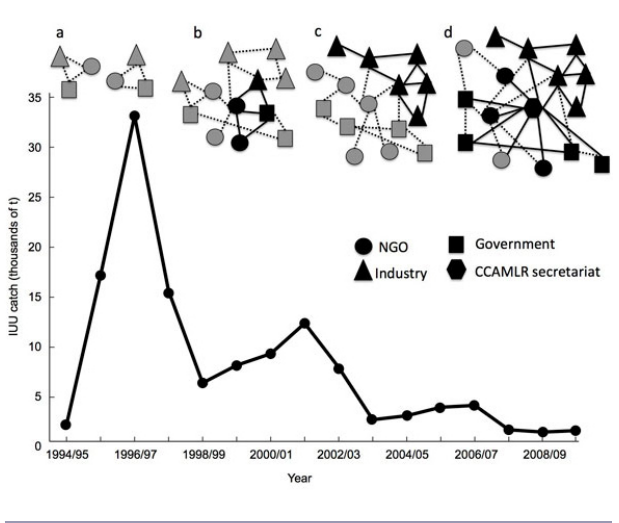
Fig. 2 . Official Commission for the Conservation of Antarctic Marine Living Resources (CCAMLR) estimates of illegal, unreported, and unregulated (IUU) fishing between 1995 and 2009 (SC-CAMLR 2010), and corresponding, simplified governance features as explained in the text. (a) Two independent networks of government (squares), nongovernmental organization (NGO) (circles), and fishing industry (triangles) actors were collaborating independently in the mid-1990s. (b) One network evolved into ISOFISH (solid black symbols and lines), and the two independent networks became connected. After ISOFISH, (c) the industry network was formalized to the Coalition of Legal Toothfish Operators (COLTO) (solid black symbols and lines), which contributed to CCAMLR as an effective institution (solid black symbols and lines). (d) The secretariat (hexagon) coordinates information